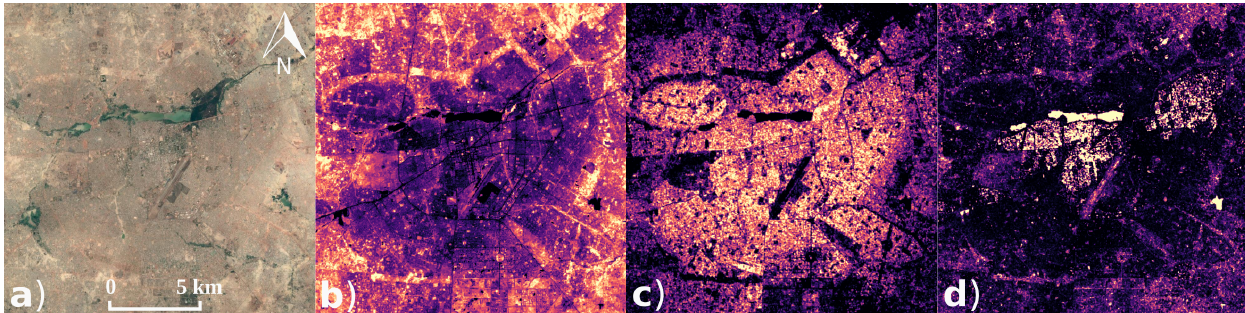
Figure 5. Subset of three features over the same area of interest in Ouagadougou, Burkina Faso: ( a ) aerial view of the area of interest, courtesy of Google Earth, ( b ) Near Infrared Landsat band, ( c ) Sentinel-1 VH 7 × 7 Grey-Level Co-Occurence Matrix (GLCM) Mean, ( d ) Sentinel-1 VV 7 × 7 GLCM